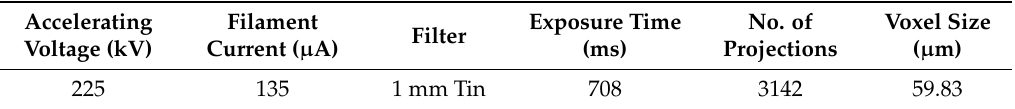
Table 4. Imaging parameters of the X-ray CT scans.